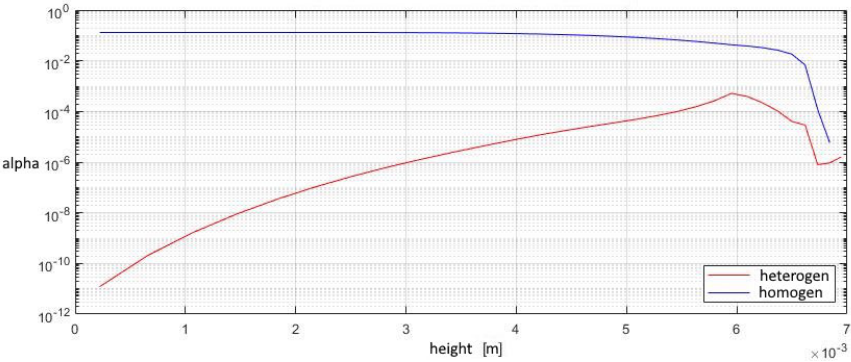
Figure 16. The mass fraction of condensed substance in the outlet section of the diffuser.